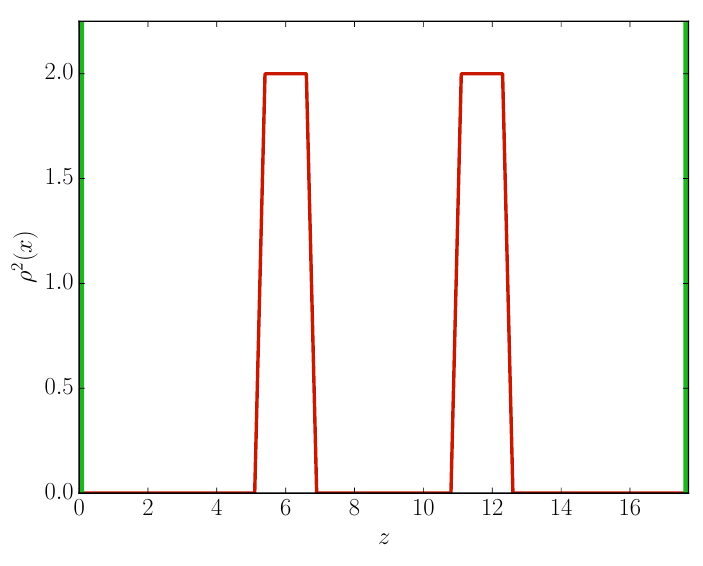
Figure 1 . The setup of the system with barriers (red) and boundaries (green). Here, (cid:17) = 1. During the time-evolution, each mode independently satis(cid:12)es the fermion equation of mo- tion (2.5). For each value of momentum k , the spin variable s takes two values for each of the two modes U and V